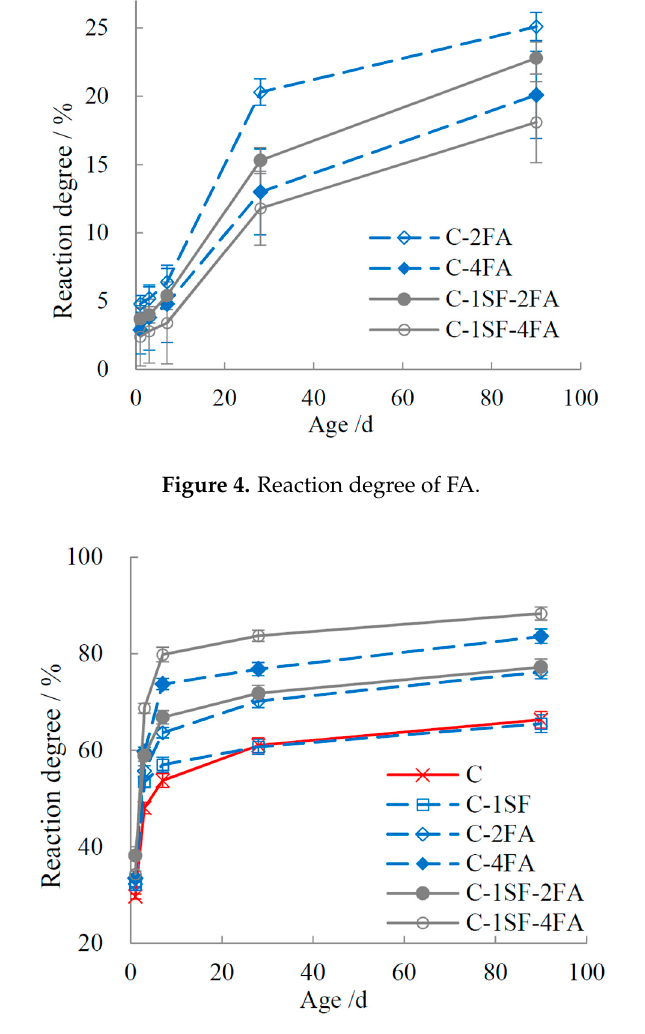
Figure 5. Reaction degree of cement.